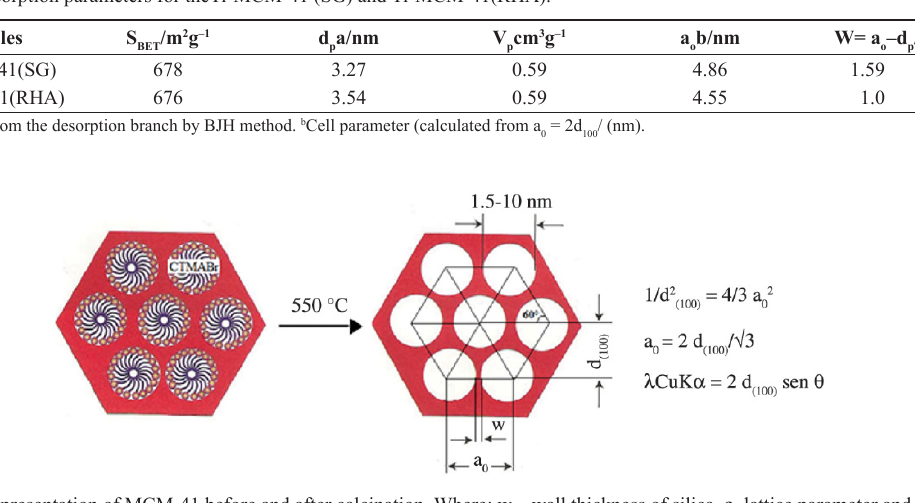
lattice parameter and d(100) - 0-